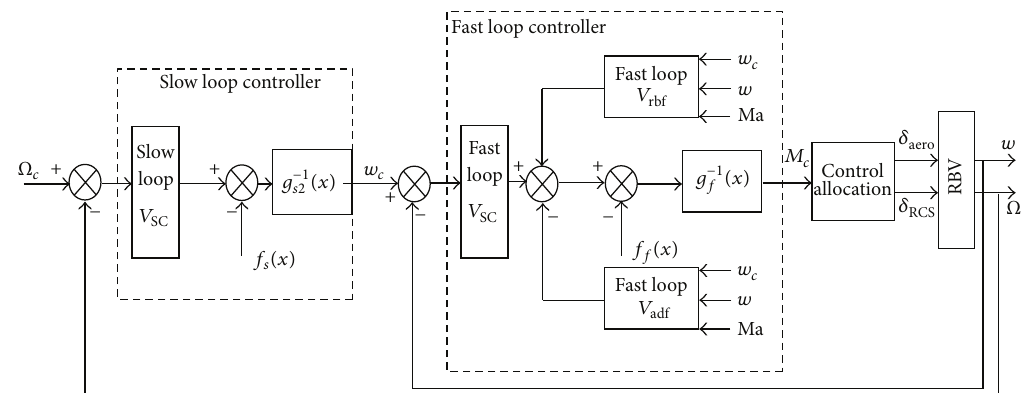
Figure 7: The structure diagram of RBV control